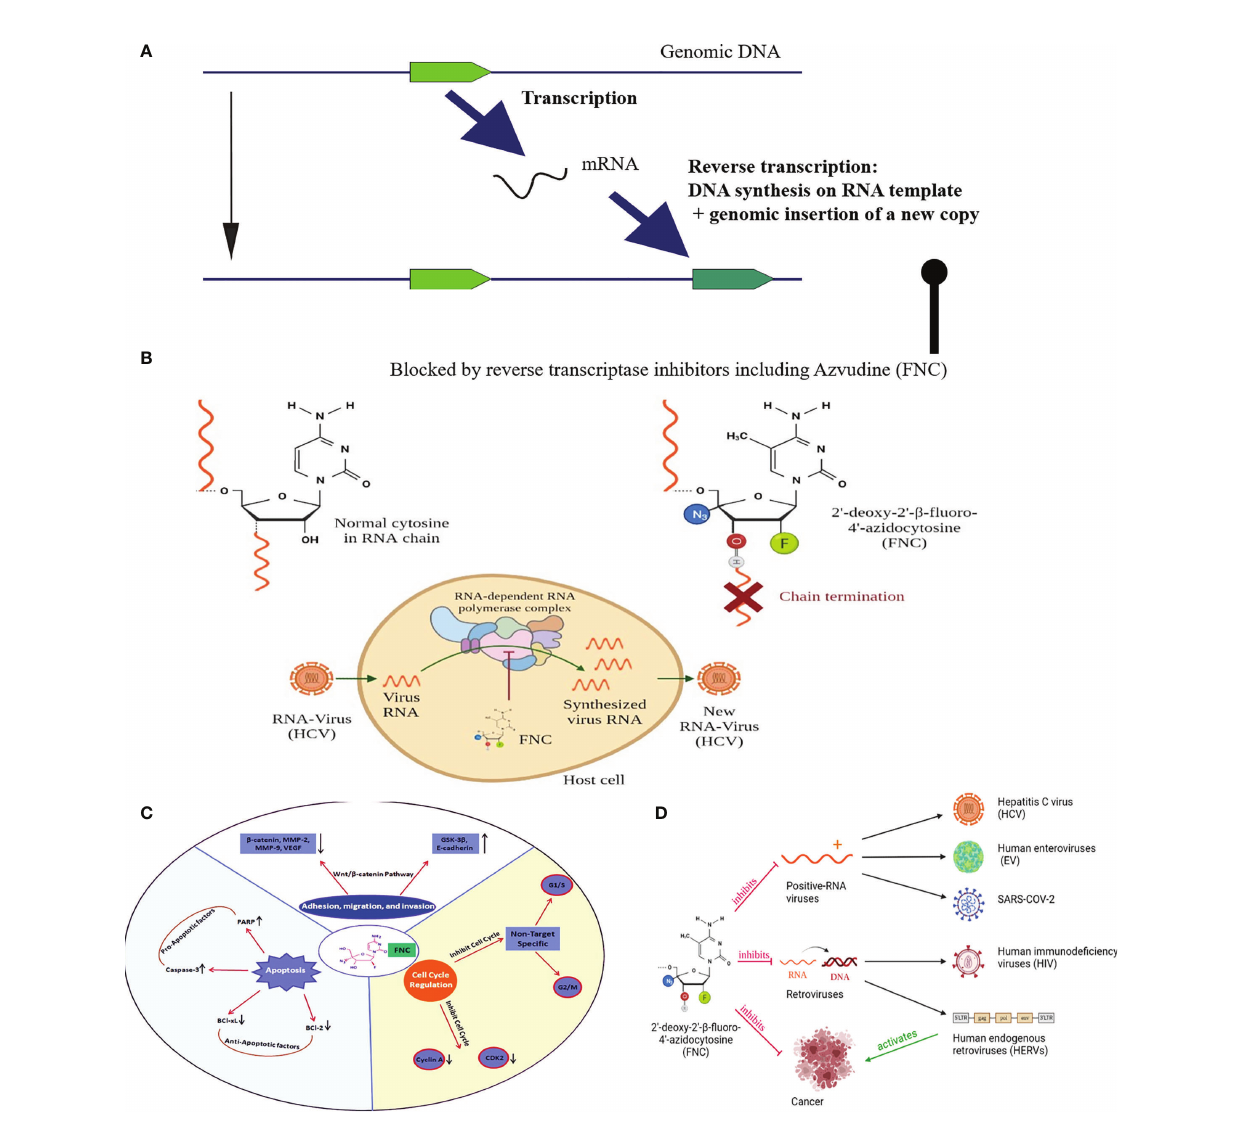
FIGURE 2 | (A) Schematic representation of retrotransposon/HERV life cycle; (B) Mechanism of FNC-triggered chain termination. The 3 ′ -OH group of FNC is unlikely to be used by polymerases for elongation of proviral RNA synthesis.; (C) Representation of antitumor mehanisms of FNC through multiple molecular pathways. FNC promotes apoptosis by decreasing Bcl-xL and Bcl-2 and activation of caspase-3 which further regulates proteolytic cleavage of many key proteins such as PARP. FNC inhibits the adhesion, migration and invasion of Raji and JeKo-1 cell lines by up-regulating the expression of E-cadherin and GSK-3 b proteins and down-regulating the expression of proteins such as b -catenin, VEGF, MMP-2 and MMP-9. Wnt/ b -catenin signaling pathway has a crucial position in the development and promotion of a wide variety of cancers. Activated Wnt/ b -catenin changing the E-cadherin- b -catenin complex expression is signi fi cantly coupled with the invasiveness of tumor cells. FNC is a cell cycle-nonspeci fi c agent which causes G1/S or G2/M phase cell cycle arrest and induces apoptosis. It inhibits cell cycle checkpoint activation (e.g., Cyclin-A binding to CDK2 permits cells to complete S phase and enter to M phase); (D) Graphic Abstract, depicts the possible mechanisms of FNC anticancer and antiviral